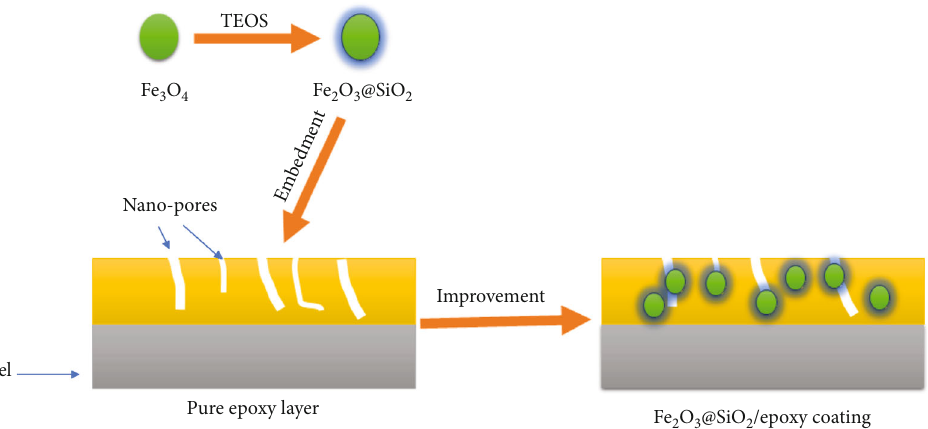
Figure 7: Schematic representation of the corrosion-resistant mechanisms of Fe